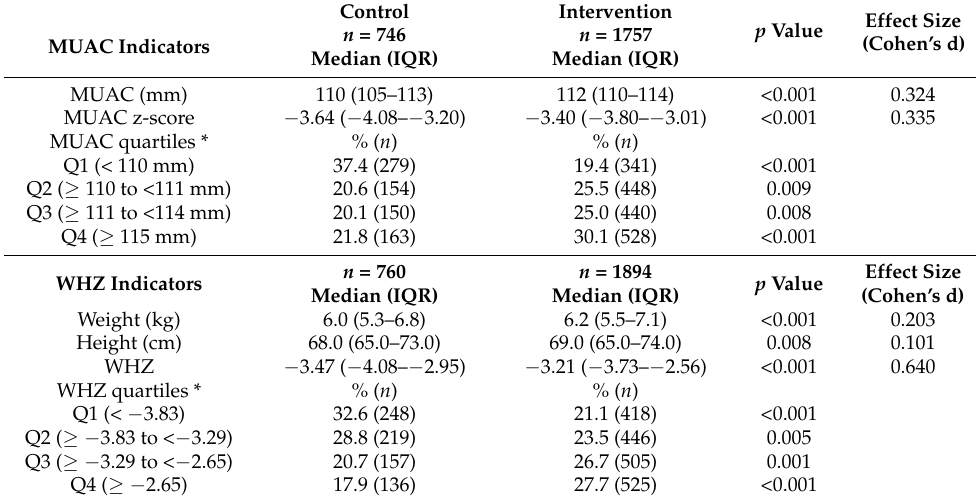
Table 2. Anthropometric severity at admission compared between study groups.